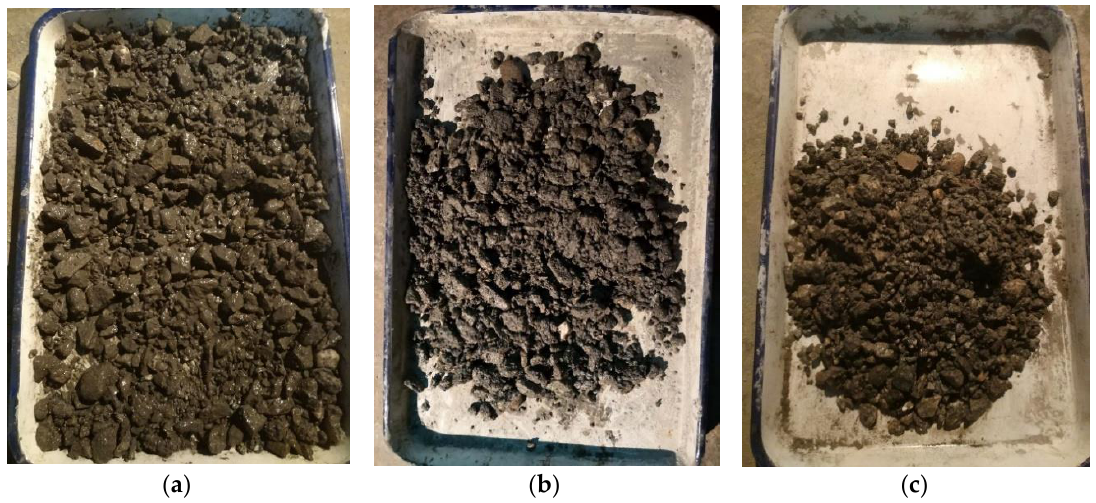
Figure 10. The unreal dry phenomenon in mixing the cement stabilized macadam materials. ( a ) 0% sodium sulfate. ( b ) 1% sodium sulfate. ( c ) 3% sodium sulfate.